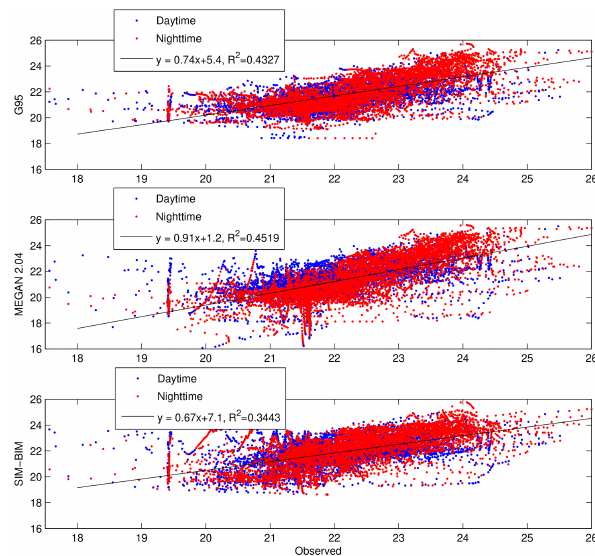
Figure 6. Scatter plots of modelled (G95, MEGAN 2.04, SIM– BIM) vs. measured hourly monoterpene concentrations on a log(moleculecm − 3 ) scale for the year 2007 data.